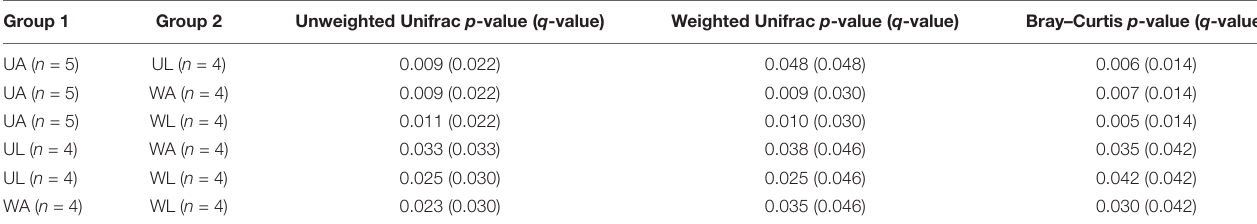
TABLE 3 | Multiple pairwise Permanova (999 permutations) tests on beta-diversity indices obtained for all combinations of samples. Group